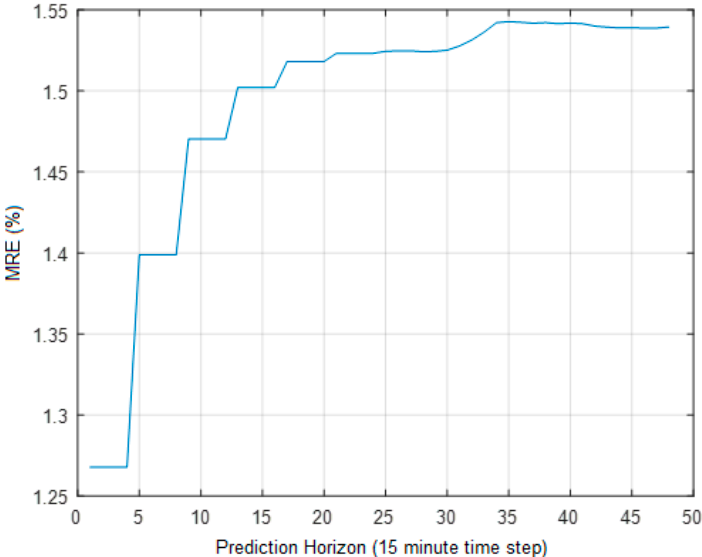
Figure 13. Mean relative error (MRE, %) of the PV power within the prediction horizon.